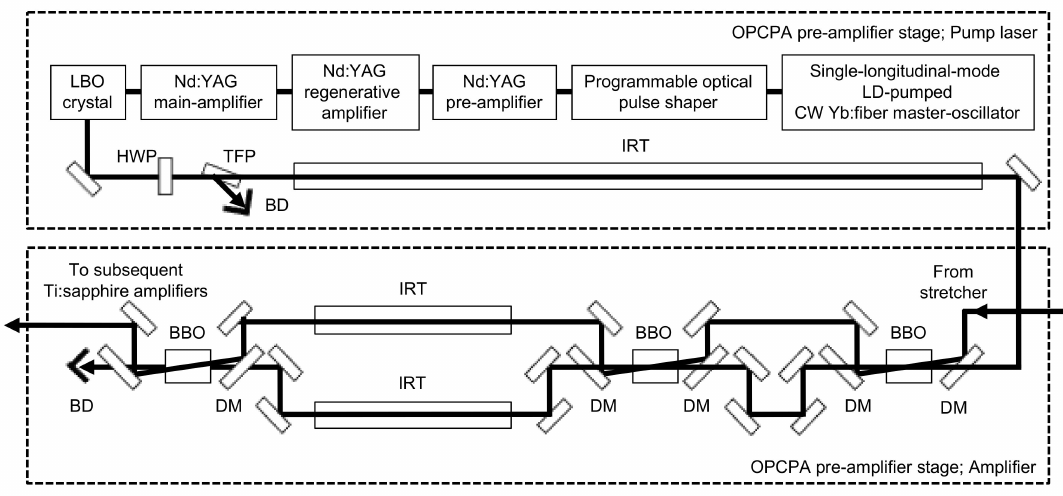
Figure 2. Detailed OPCPA pre-amplifier layout. TFP, thin-film polarizer; HWP, half-wave plate; BDs, beam dumpers; IRTs, image relay telescopes; DMs, dichroic